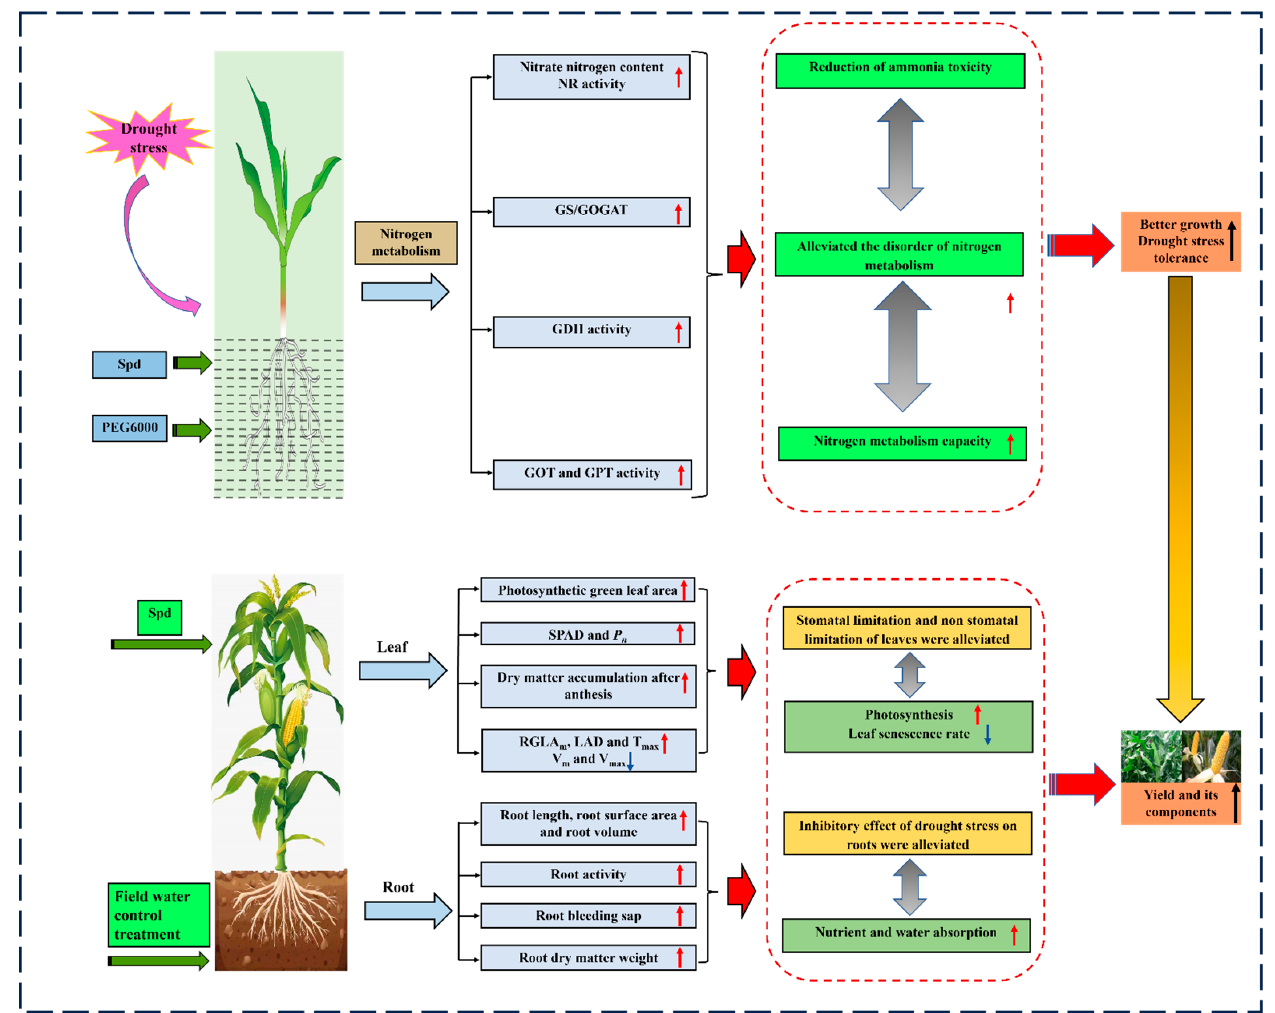
Figure 5. Schematic representation of the positive role of exogenous spermidine on nitrogen metabolism and transcriptome analysis in maize under drought stress and field verification. The red arrows ( ) and the blue arrows ( ) represent the positive and passive roles of spermidine, respec ‐ tively.